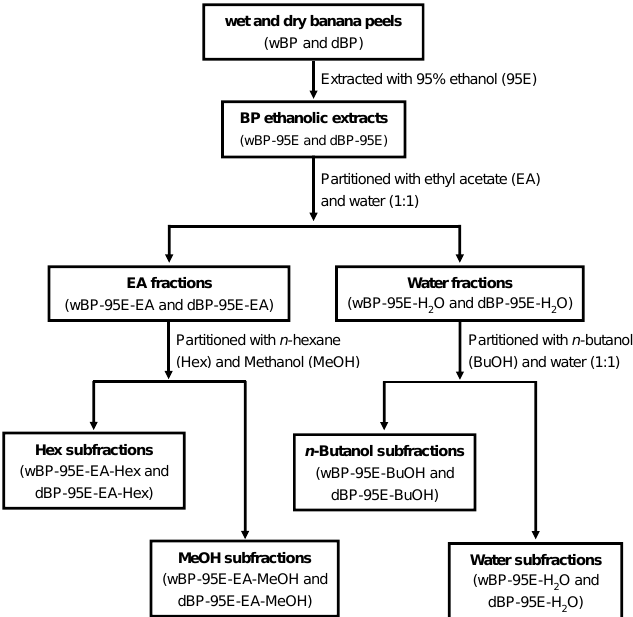
Figure 1. Extraction, separation, and fractionation of anti-inflammatory components from banana peel. BP-95E-H 2 O-BuOH subfractions exhibited the most potent anti-inflammatory and T-cell im- munomodulatory properties.2.3. Gas Chromatography – Mass (GC – MS) Spectrometry Analysis.